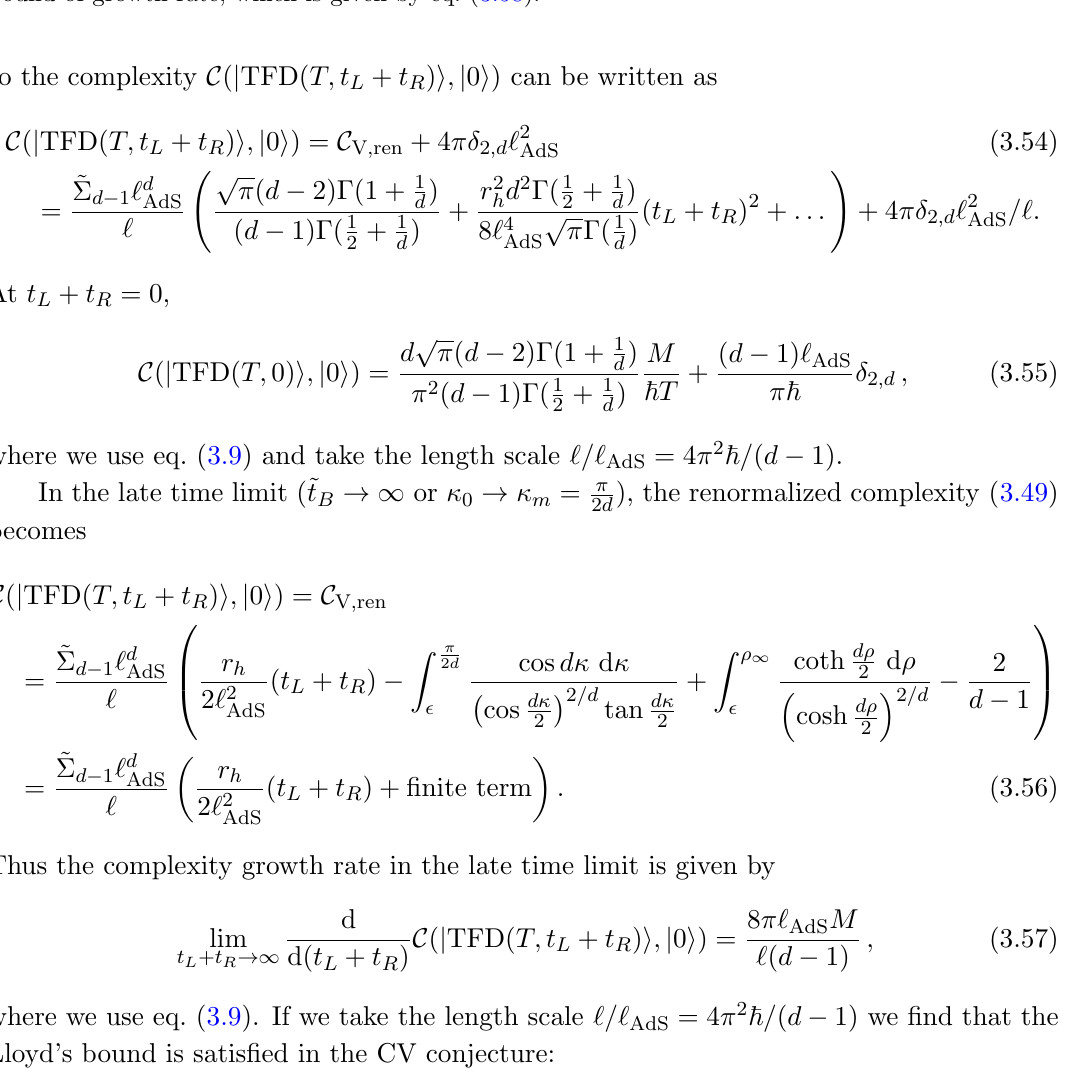
Figure 5 . The values of C ( j TFD( T; t L + t R ) i ; j 0 i ) and its growth rate when d = 2 ; 3 ; 4 ; 5. The higher dimensions give similar results. C 0 is the complexity when t L + t R = 0 and _ C f is the Lioyd’s bound of growth rate, which is given by eq.